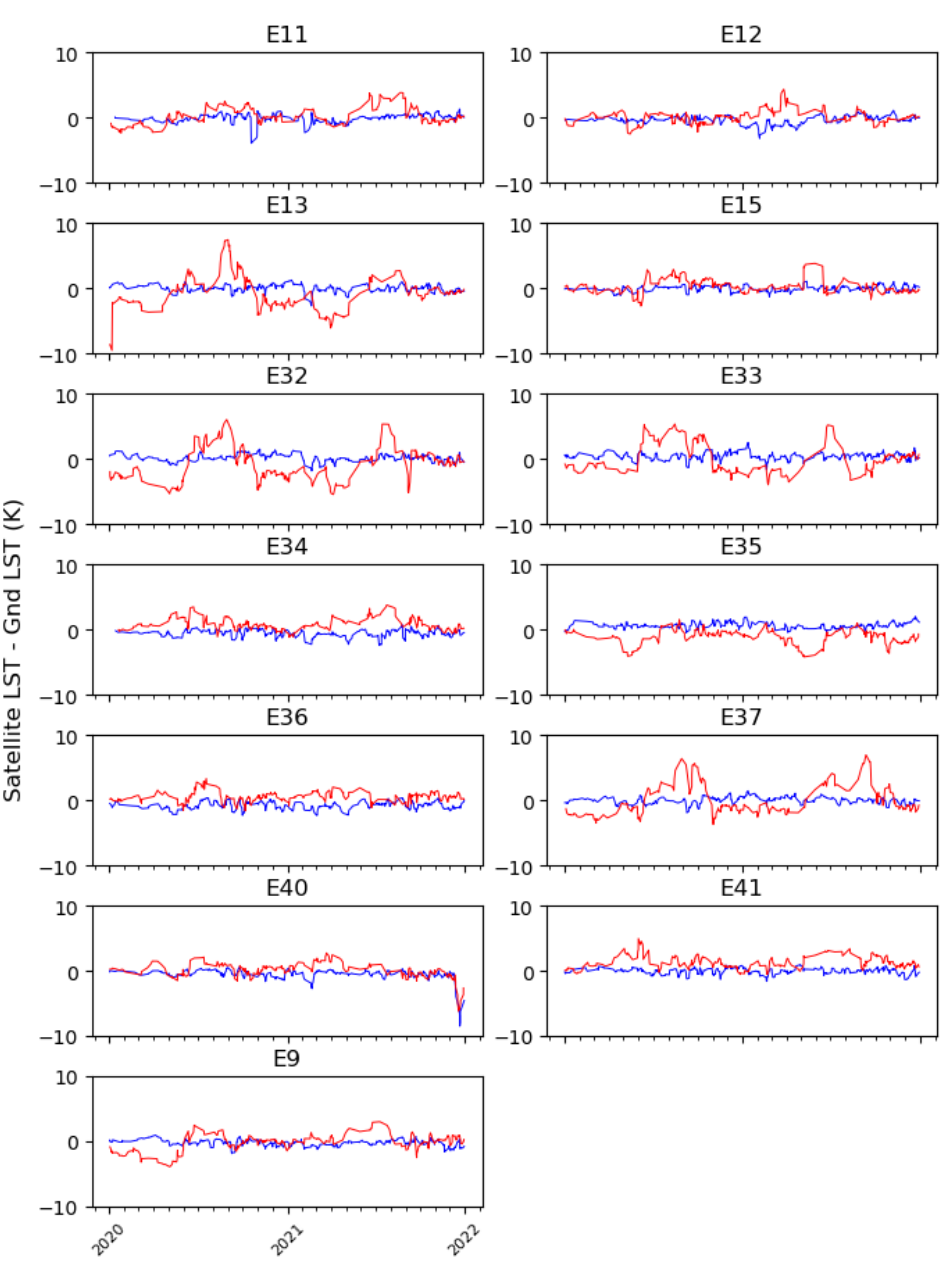
Figure 11. Time series of SNPP LST errors in each ARM site from 2020 to 2022 (blue color for nighttime and red color for daytime).